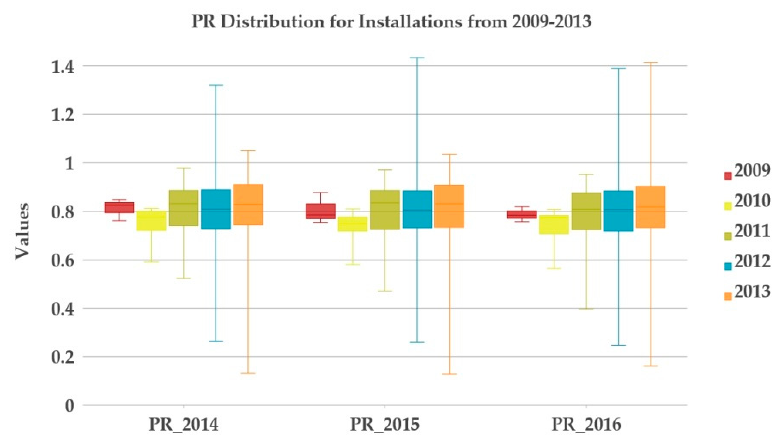
Figure 5. Distribution of performance ratio of the Netherlands between 2014 and 2016 for systems that have been installed from 2009 to 2013.